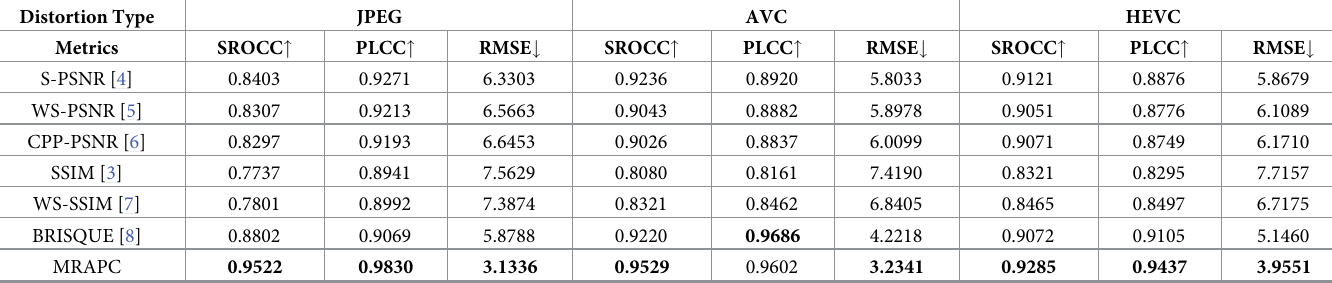
Table 3. Performance comparison of methods under different distortion types.